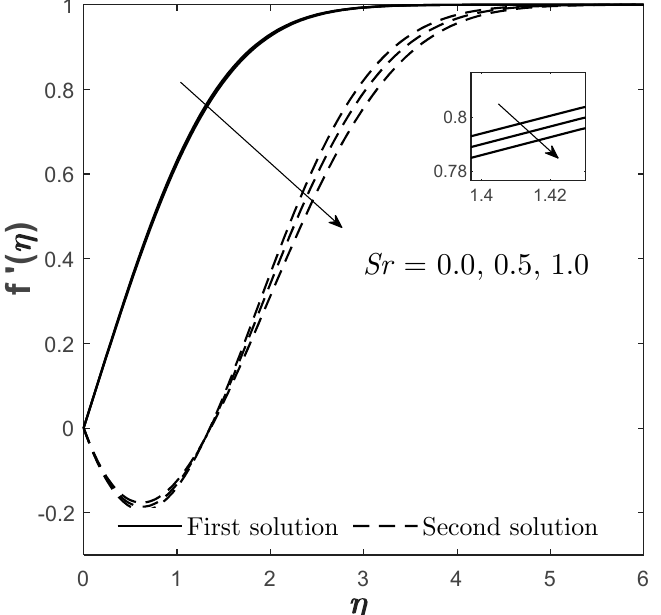
Figure 17. Plots of f (cid:48) ( η ) for varied Sr when N = Rd = Sc = 1, Du = 0.03, λ = − 1, φ 2 = 0.01, and Bi =